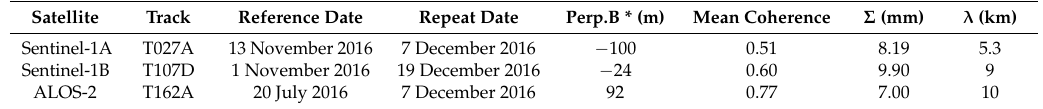
Table 1. Interferograms used in this study.